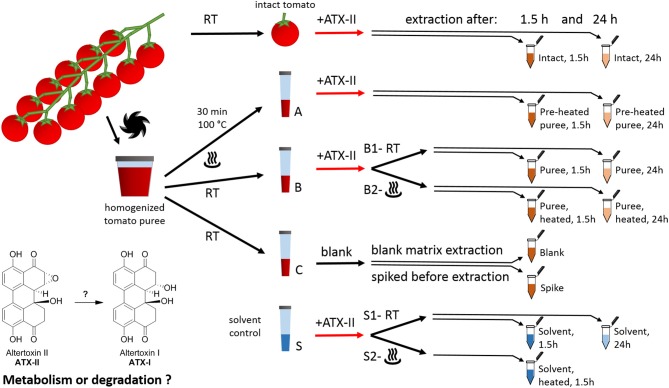
Study design for investigating the fate of altertoxin II in tomato commodities taking into account mechanical and thermal processing steps.